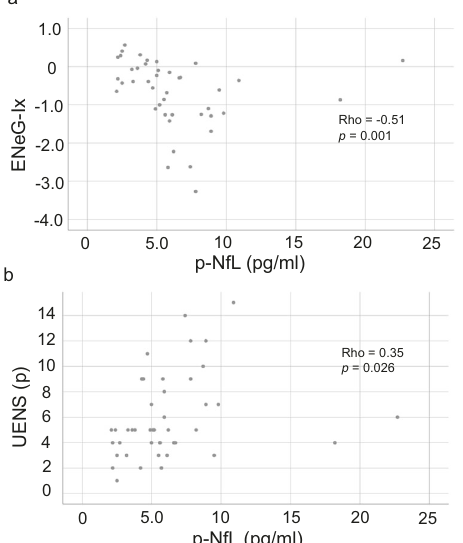
Fig. 3 Associations between p-NfL and functional peripheral nerve parameters. Associations between measures of large fi ber function, as assessed by nerve conduction studies ( a ) and UENS ( b ), and p-NfL. Correlation coef fi cients and p -values calculated with partial Spearman ’ s rank order correlation adjusting for age and sex (ENeG-Ix: ρ = − 0.51, p = 0.001; UENS: ρ = 0.35, p = 0.026). p -Values not adjusted for multiple comparisons.